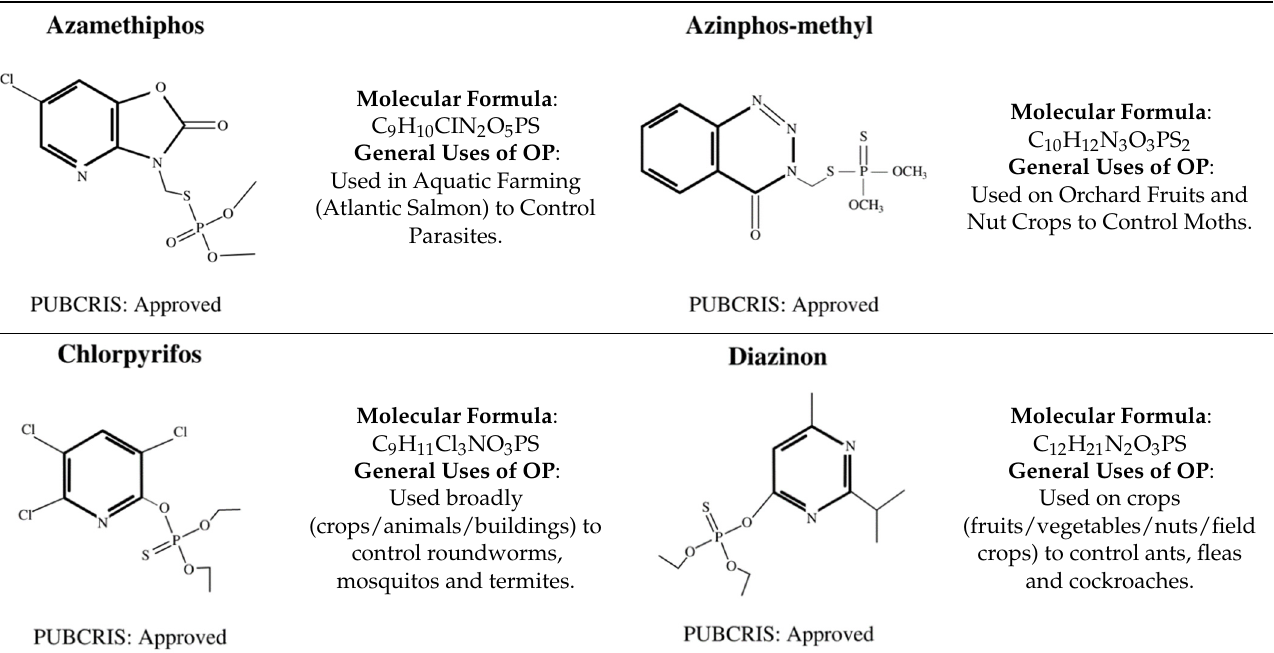
Table 1. Commonly used organophosphate (OP) insecticides in agriculture and aquaculture. Shown here are approvals using the Public Chemical Registration Information System Search (PubCRIS), molecular formula and general uses.